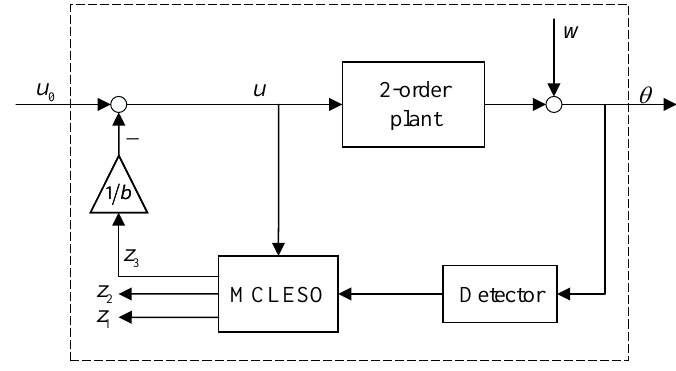
Figure 3. The block diagram of MCLESO for second-order